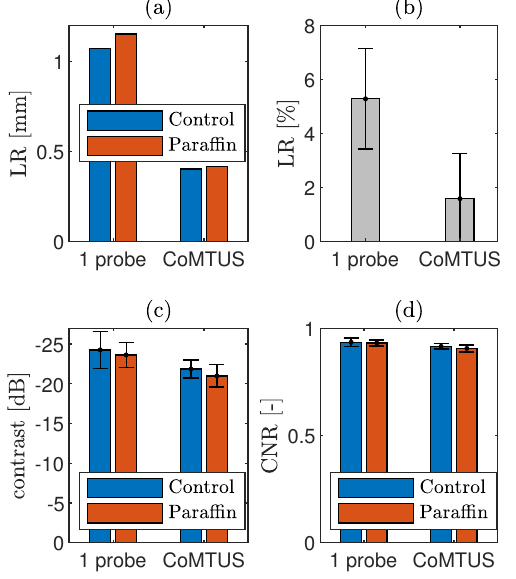
Figure 13. Experimental images of the control and the paraffin cases. Two different methods are compared: ( a ) one probe; and ( b ) CoMTUS.